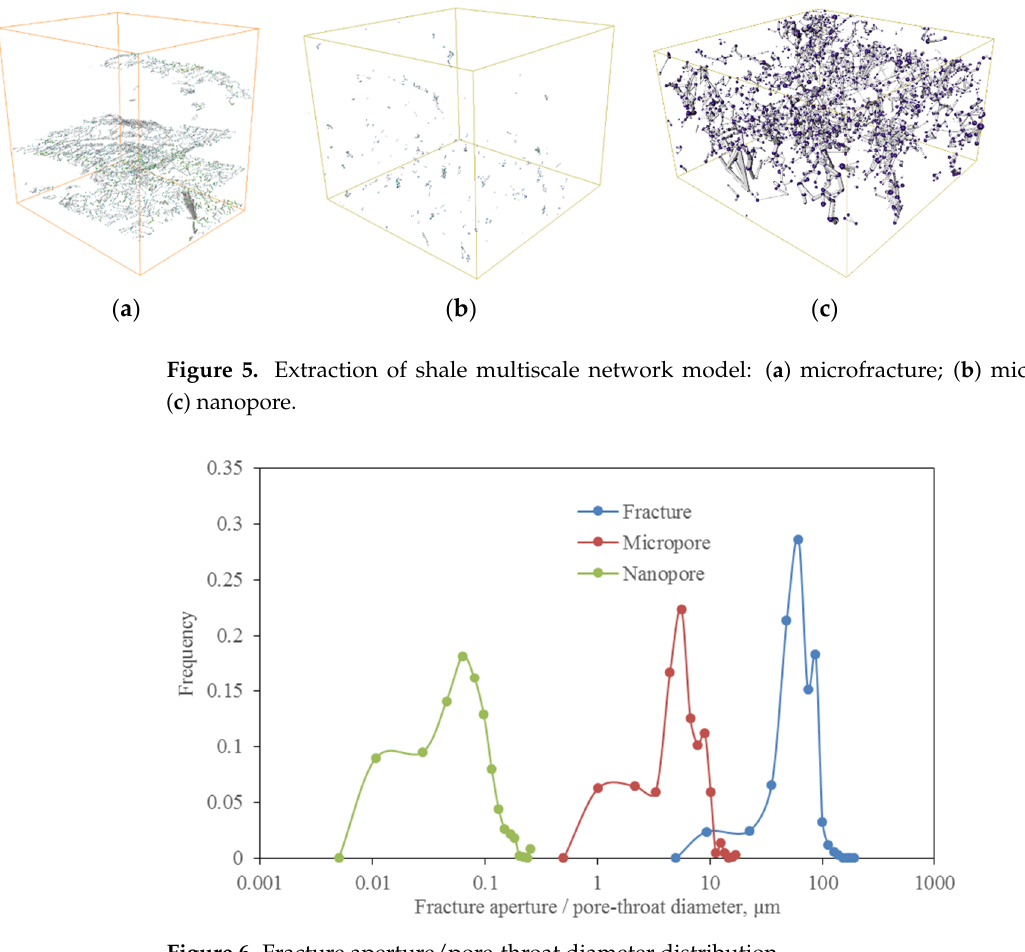
Figure 7. Coordination number distribution. Based on the different phases at different scales, the nanopore characteristics of na- nopore digital rock were fused into the micro-matrix phase of the micropore digital rock, which could obtain the micro/nano pore characteristics. Then, the micro/nano pore char- acteristics were further fused into the macro-matrix phase of the microfracture digital rock, which can totally obtain the microfracture and micro/nano pore characteristics. With this multiscale digital rock platform, the corresponding specific surface area of the shale rock can be calculated as follows: